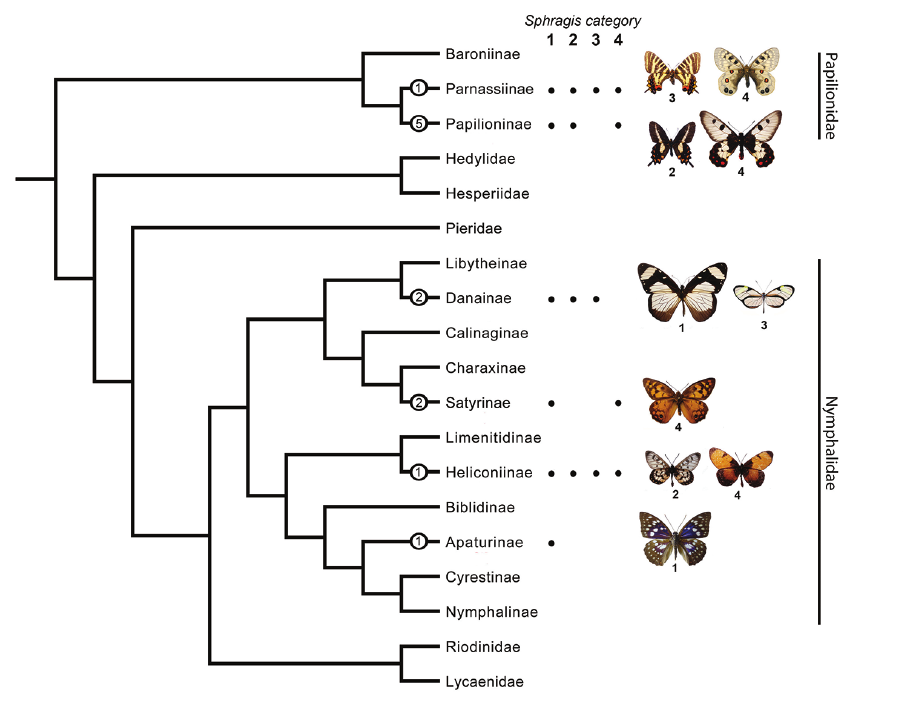
Figure 36. The occurrence of the sphragis in butterfly subfamilies. Dark circles indicate that some species in the clade bear sphragides or a version of it. Numbers inside the dark circles indicate estimation of mini- mum number of sphragis evolution events. Numbers under butterfly images indicate sphragis category of that species. Tree adapted from the phylogeny of Heikkila et al.